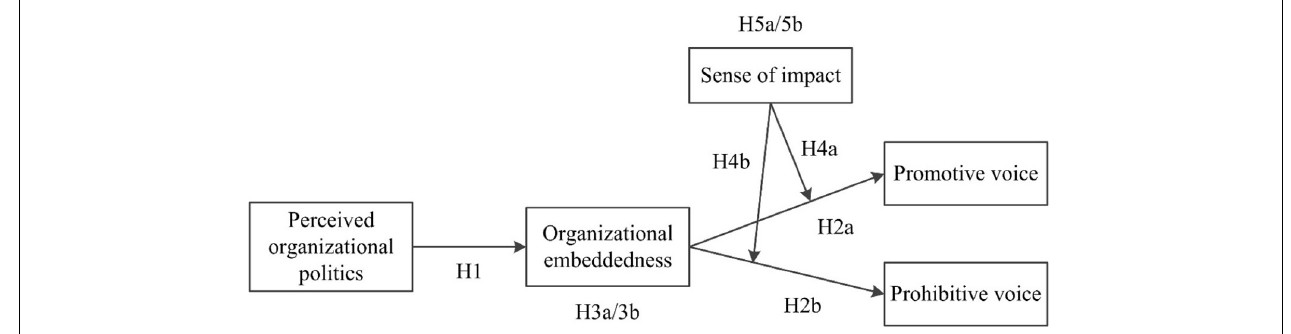
FIGURE 1 | The conceptual